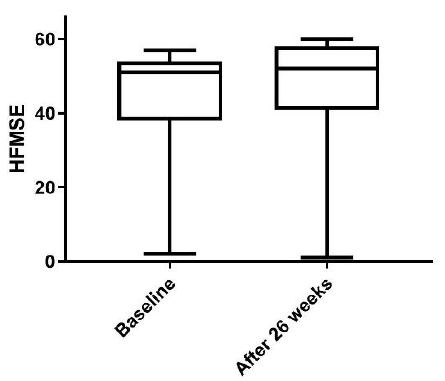
Figure 1. Changes in HFMSE in all 11 patients measured before the first administration and four months after the fourth administration of nusinersen. The box plot shows minimum to maximum range and mean.